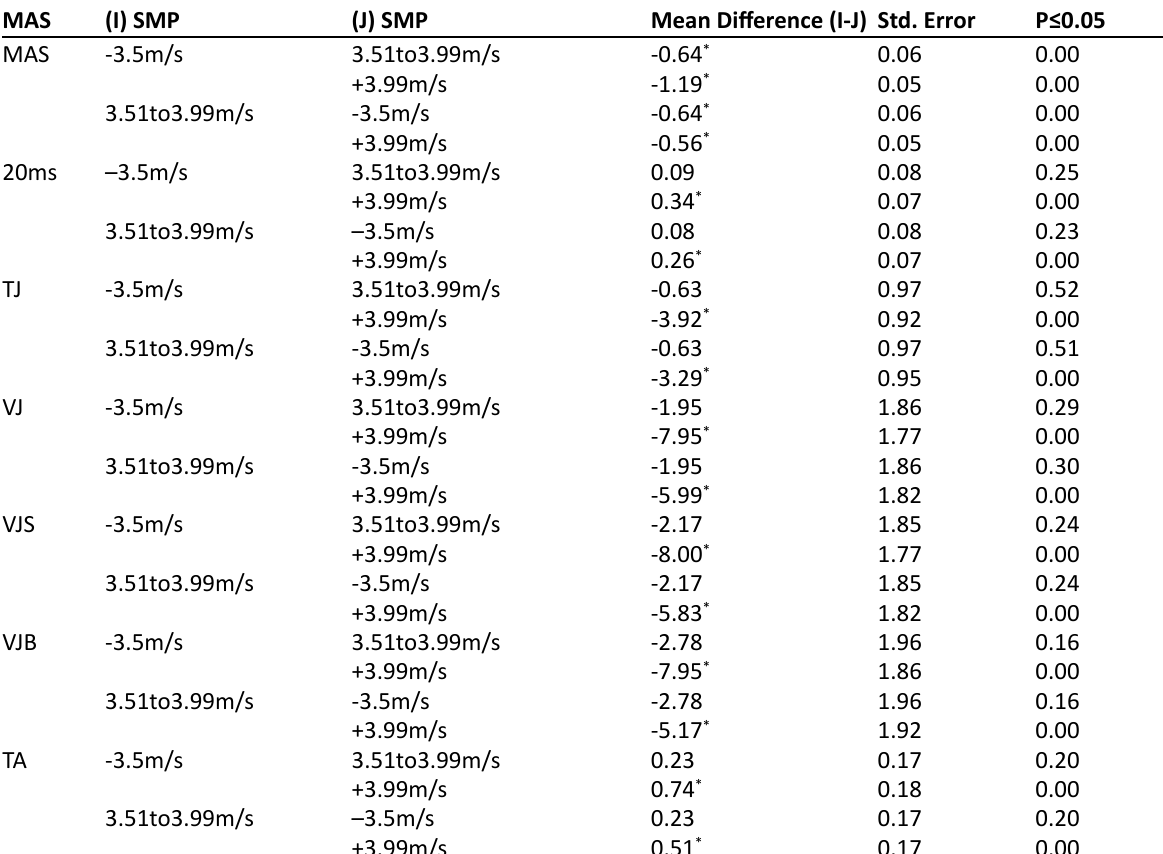
Table 2. Present differences between MAS levels and players levels skill volleyball physically ability.